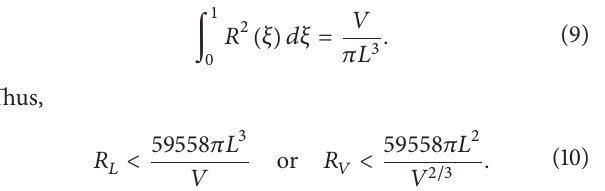
that on a plate with the use of the Mangler-Stepanov